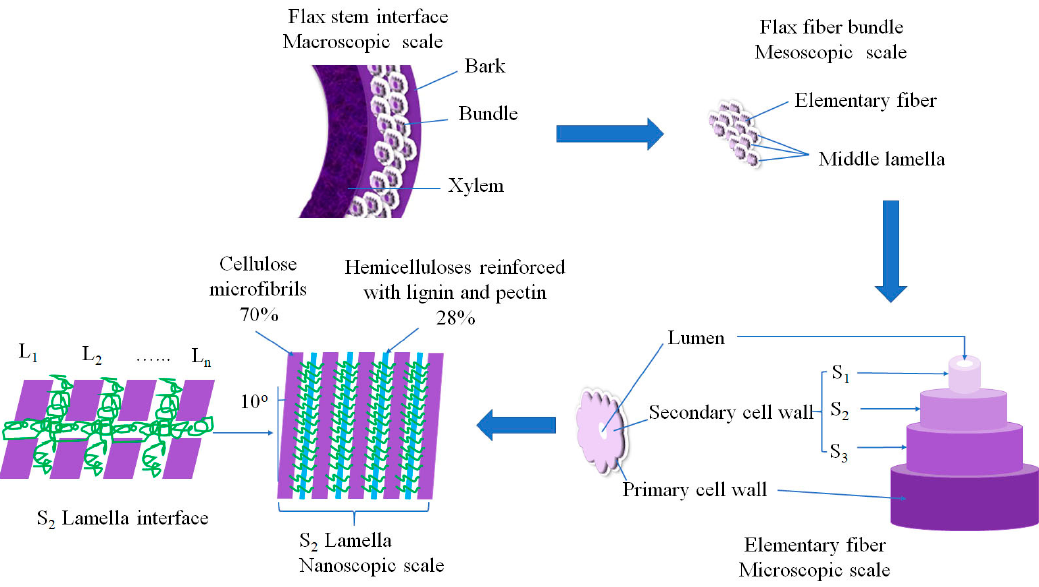
Figure 11. Structural diagram of a flax fiber.